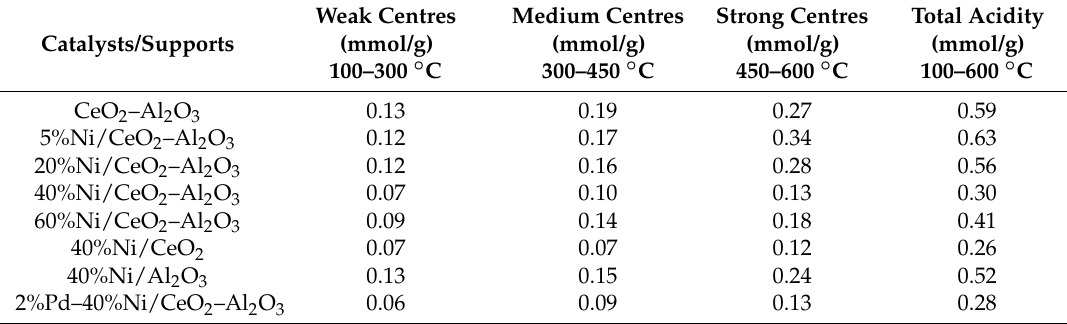
Table 3. The amount of NH 3 adsorbed on supports, monometallic nickel and bimetallic Pd–Ni/CeO 2 –Al 2 O 3 catalysts calcined in air atmosphere at 400 °C from the TPD–NH 3 data. Catalysts/Supports